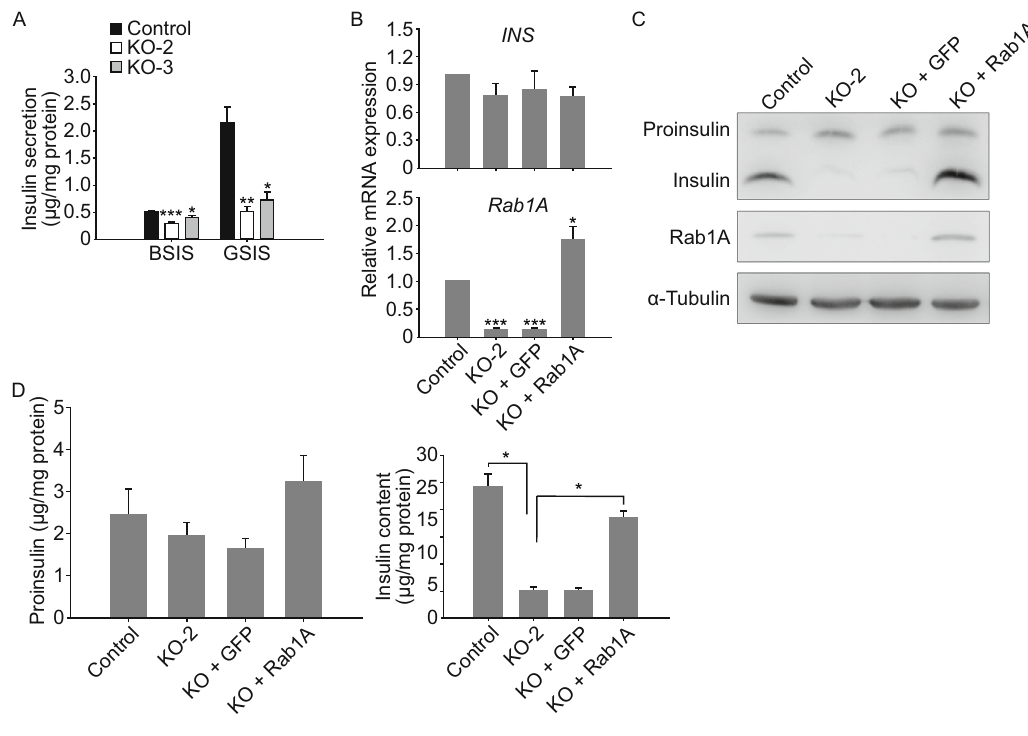
Figure 1. Insulin content is decreased in rab1a knockout INS-1E cells . (A) Insulin secretion was detected in INS-1E cells (Control) and rab1a knockout cells (KO-2 and KO-3). Insulin secretion levels were measured using a rat insulin ELISA kit. (B) Measurements of ins and rab1a mRNA expression levels in INS-1E cells (Control), rab1a knockout cells (KO-2 and KO + GFP) and exogenous rab1a expression cells (KO + Rab1A) by RT-PCR. (C) Measurements of proinsulin and insulin contents in the cells as described in Fig. 1B by Western blotting. (D) Measurements of proinsulin and insulin contents in the cells as described in Fig. 1B using the rat proinsulin ELISA kit (left panel) and insulin ELISA kit (right panel), respectively. The results of (A) and (C and D) are presented as the mean ± S.E.M. ( n = 3). *, P < 0.05; **, P < 0.01; ***, P